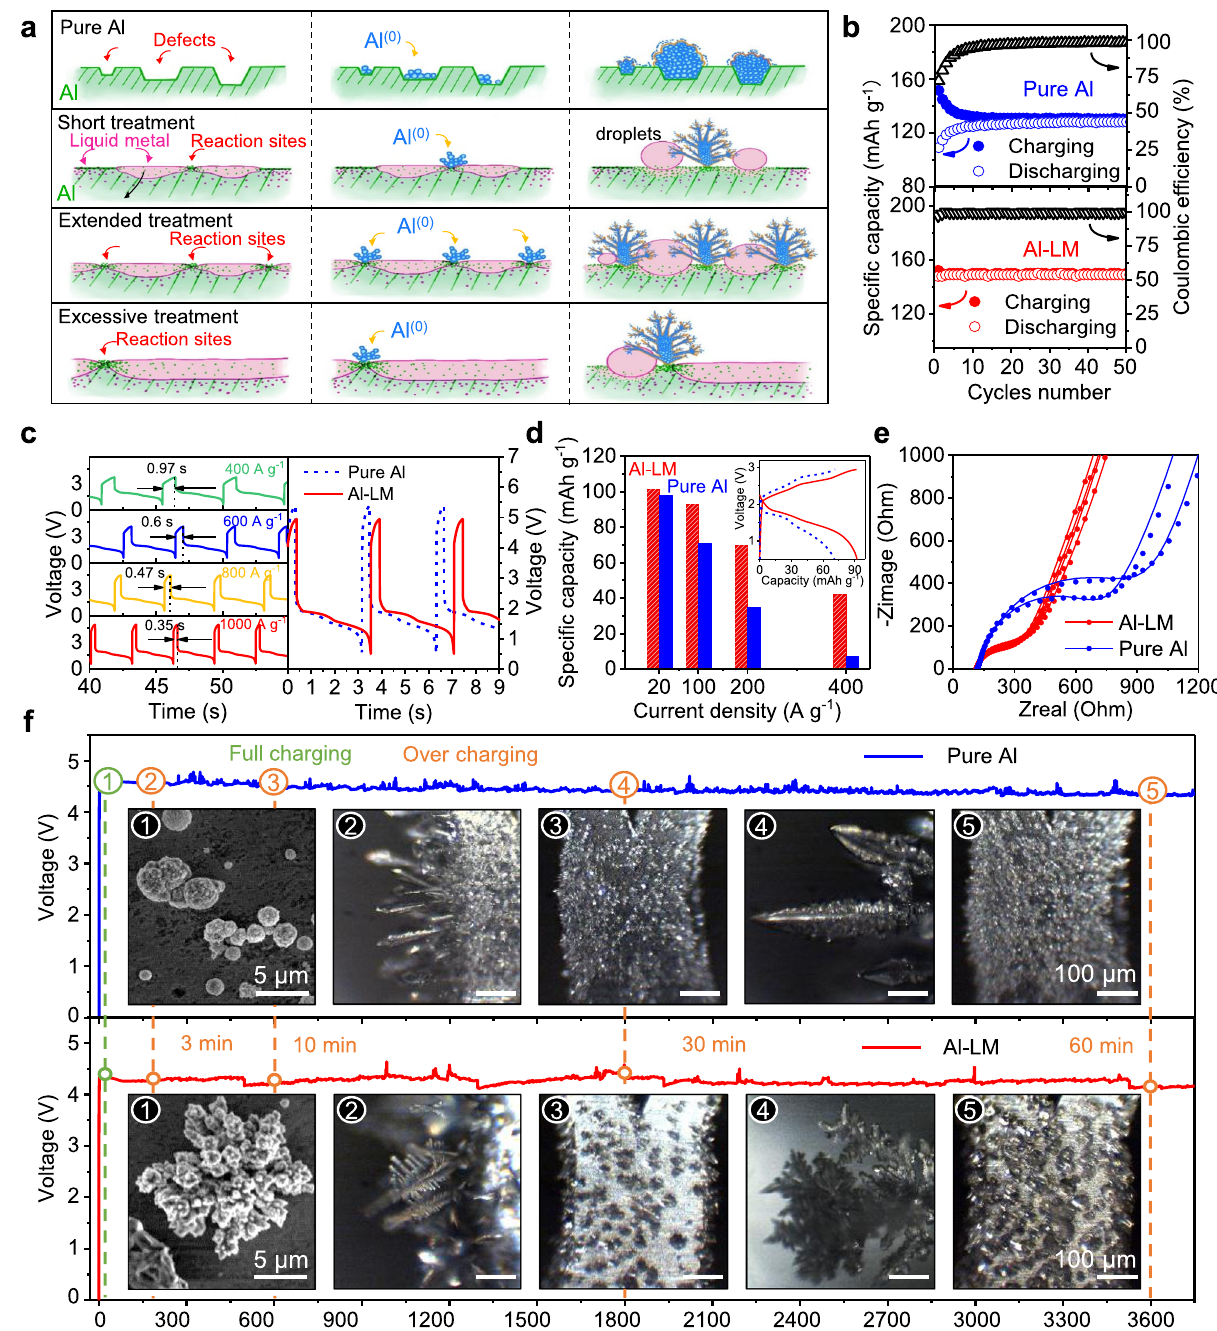
Fig. 2 Active anode (Al-LM) promotes easy Al plating. a Schematic illustration of the plating of Al adatoms on pure Al versus that on Al-LM. b Active anode behaves differently from a pure Al anode, where no delay in speci fi c capacity and Coulombic ef fi ciency were observed. c Al-LM promotes an ultrafast charging with excellent speci fi c capacity ( i c = 400~1000Ag − 1 , i dc = 100 Ag − 1 ), where a mere 0.35 s can charge the battery to its full capacity. Compared with pure Al anode, the active anode requests a lower charging voltage and exhibits longer time of discharging duration ( i c = 1000 A g − 1 , i dc = 100 A g − 1 ). d Bar graphs of active anode vs. pure Al anode in producing better speci fi c capacity under high rates. Saturation voltage of Al-LM anode was used as cut-off voltage for both cases. (Inset) Charge and discharge curves at a current density of 100 A g − 1 (graphene parameters: 0.025 mg; 0.22 mgcm − 2 ). e Electrochemical impedance spectroscopy (EIS) reveals pure Al anode higher resistance than the active anode. f Over-charging of Al-ion batteries with two different anodes (Al vs. Al-LM, i c = i dc = 400Ag − 1 ). ① SEM images of full-charging show early morphologies drastically different (scale: 5 µ m); and ② - ⑤ are optical microscopy images of front- and side-views of plated Al (scale: 100 µ m).